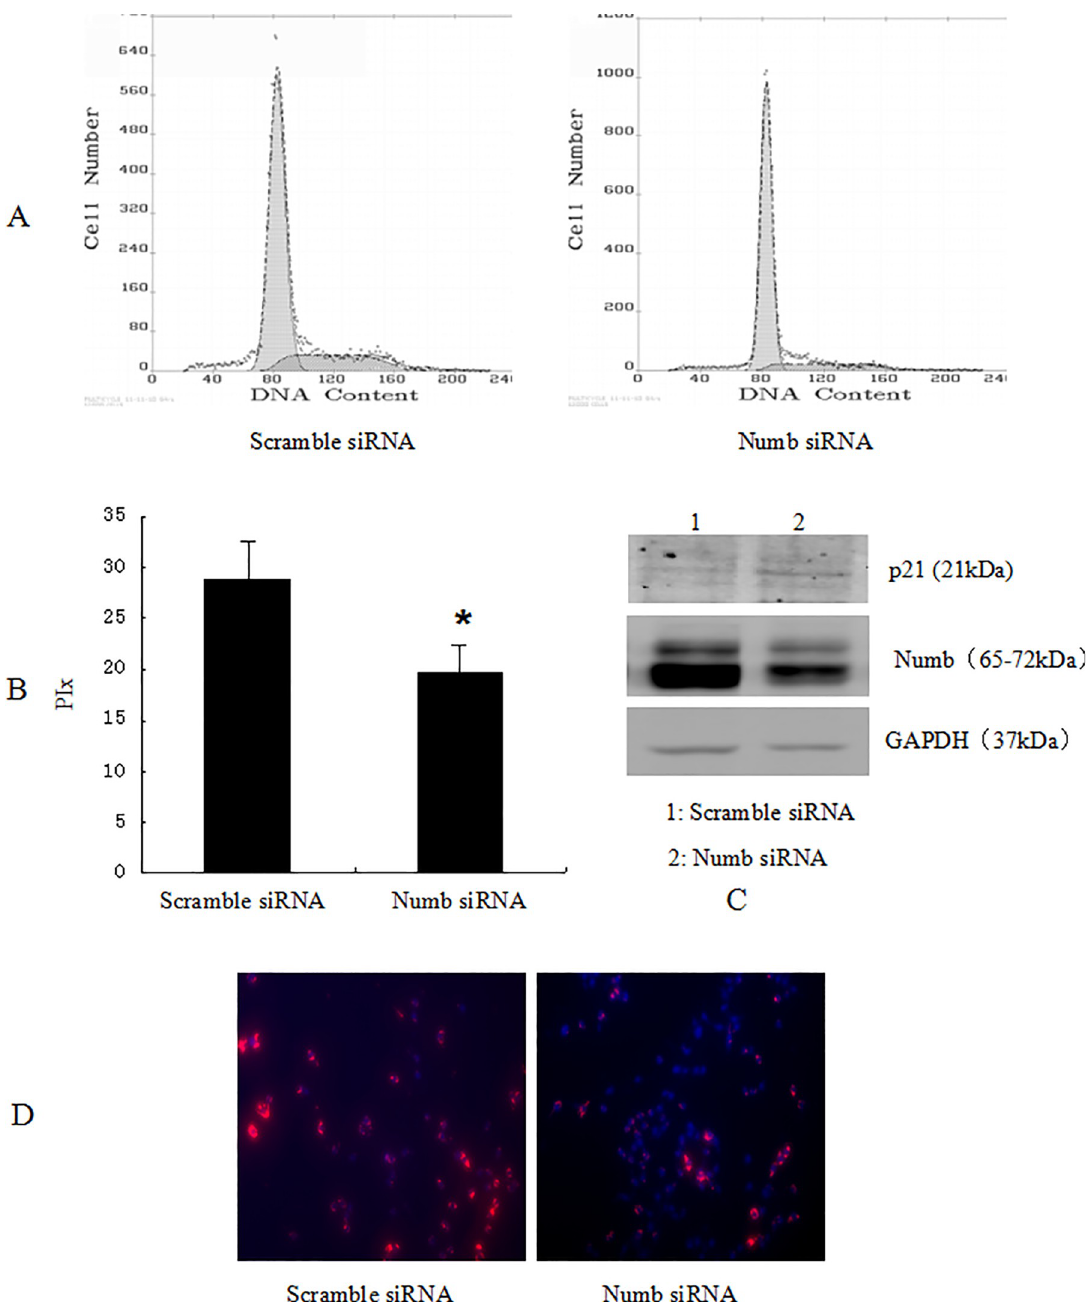
Fig 6. Knockdown of Numb up-regulated the expression of p21, inhibited SMMC-7721 cell cycle progression. SMMC-7721 cells were transfected with scramble siRNA, Numb siRNA, respectively. 48 h after transfection, the amount of Numb and p21 was determined by antibodies specific for Numb and p21(C). (A)Cell cycle was analysed by FACSCalibur (Becton Dickinson, Mountain View, CA). The proliferative index (PIx) decreased compared to control (P < 0.05, B). For BrdU incorporation analysis (D), the cells were incubated with a mouse monoclonal anti-BrdU antibody overnight at 4˚C, and were incubated with fluorescein isothiocyanate-conjugated goat antimouse IgG for 1 h at room temperature. Hoechst 33342 was used to label nuclei (red). Photographs were taken using a Nikon microscope. Magnification100x. The proliferation cells (red) decreased